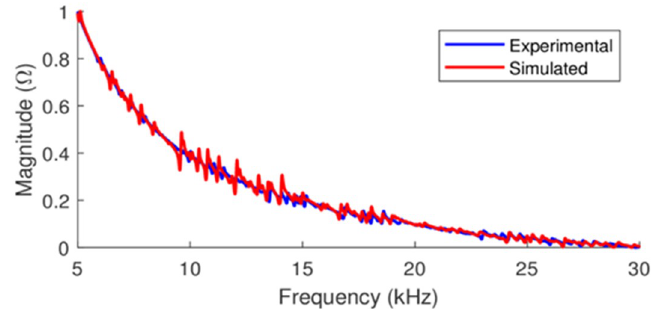
Figure 3. Normalized electrical impedance signatures for pipe-1/PZT-1: experimental and simulated.